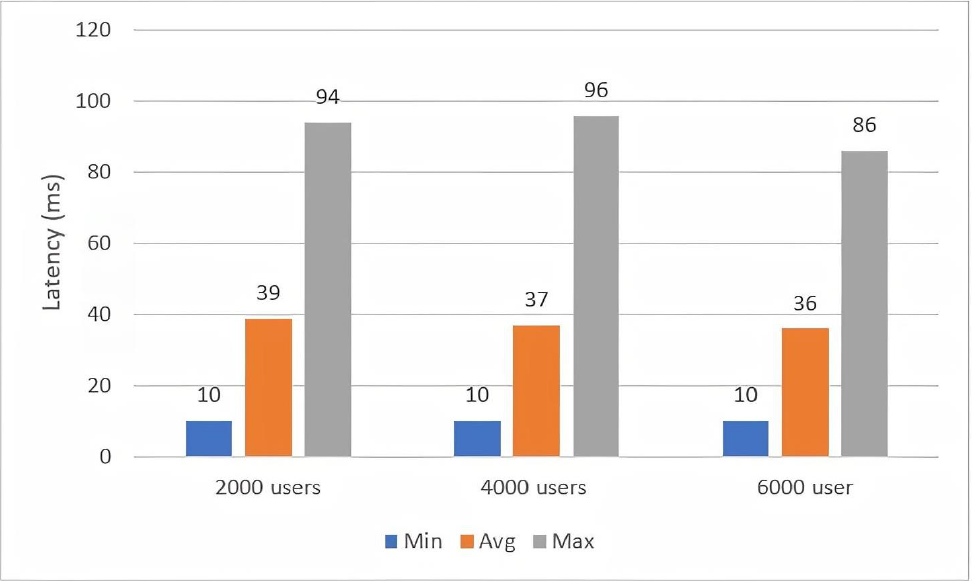
Figure 8. Performance assessment for query